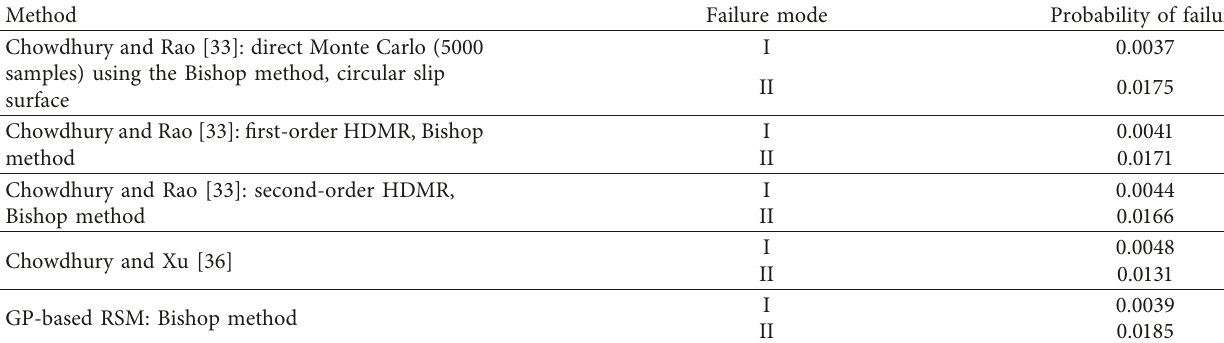
Table 14: Results of probabilistic analyses using different methods for Example